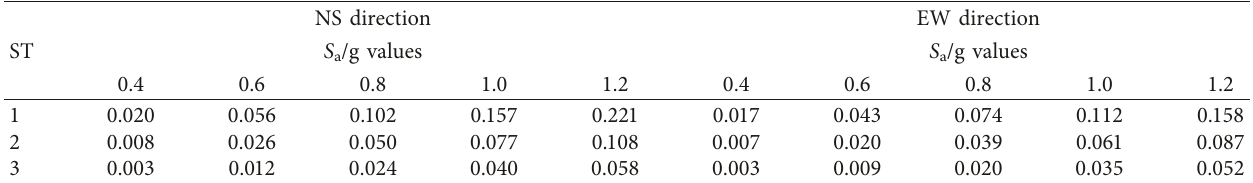
Table 7: Mean values of E